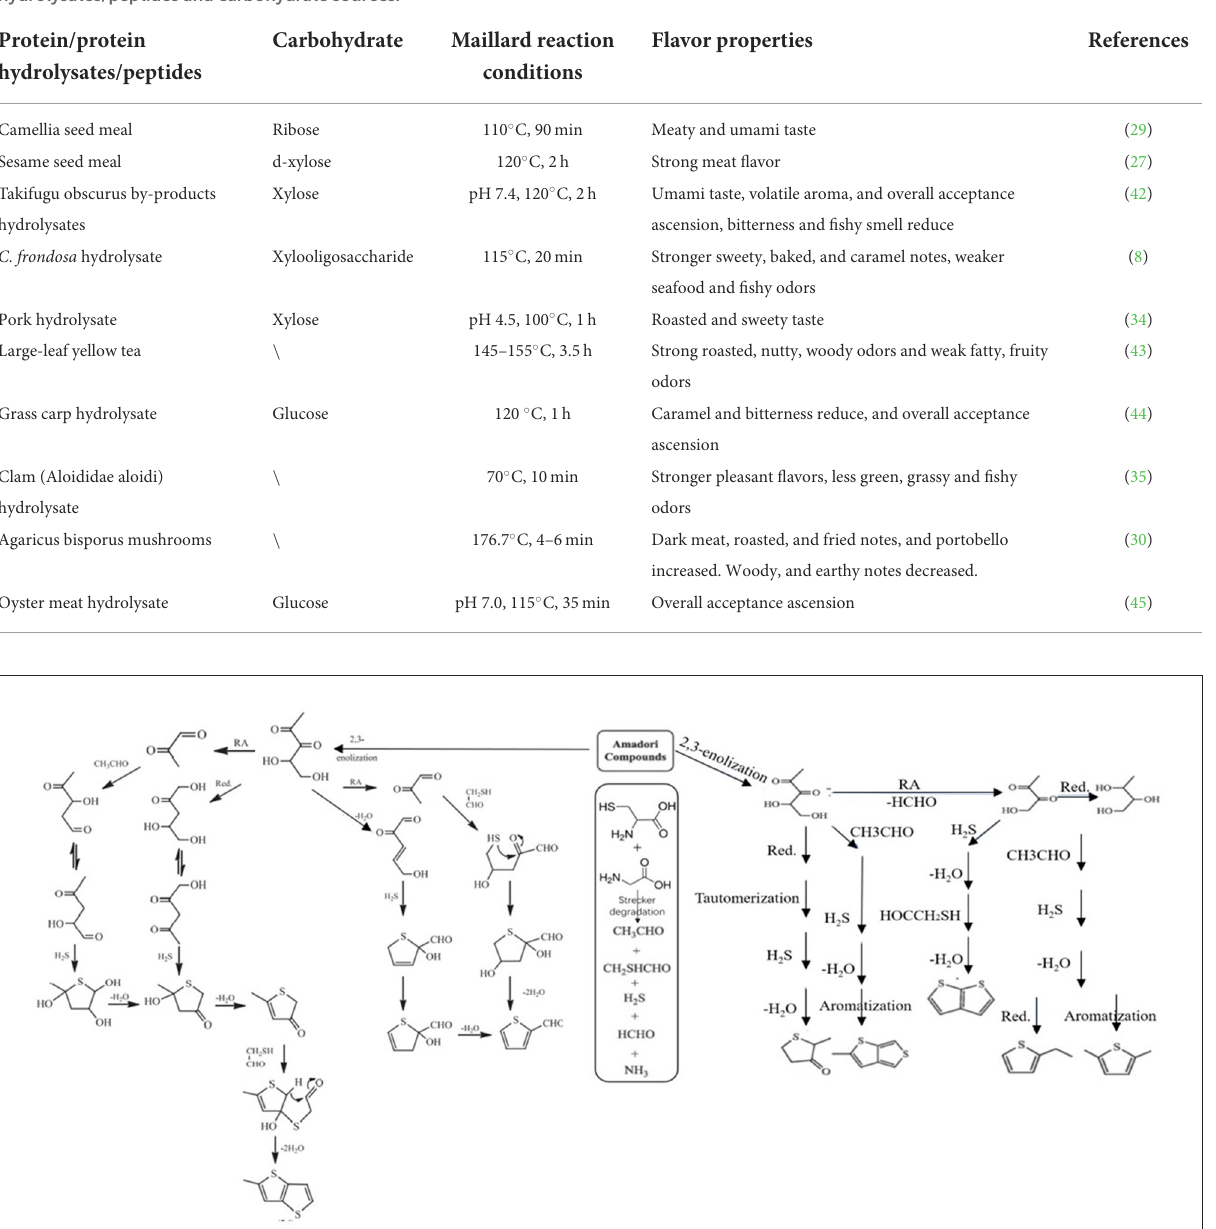
TABLE 2 Summary of the recent studies on flavor properties of Maillard reaction products generated from various protein/ protein hydrolysates/peptides and carbohydrate sources.